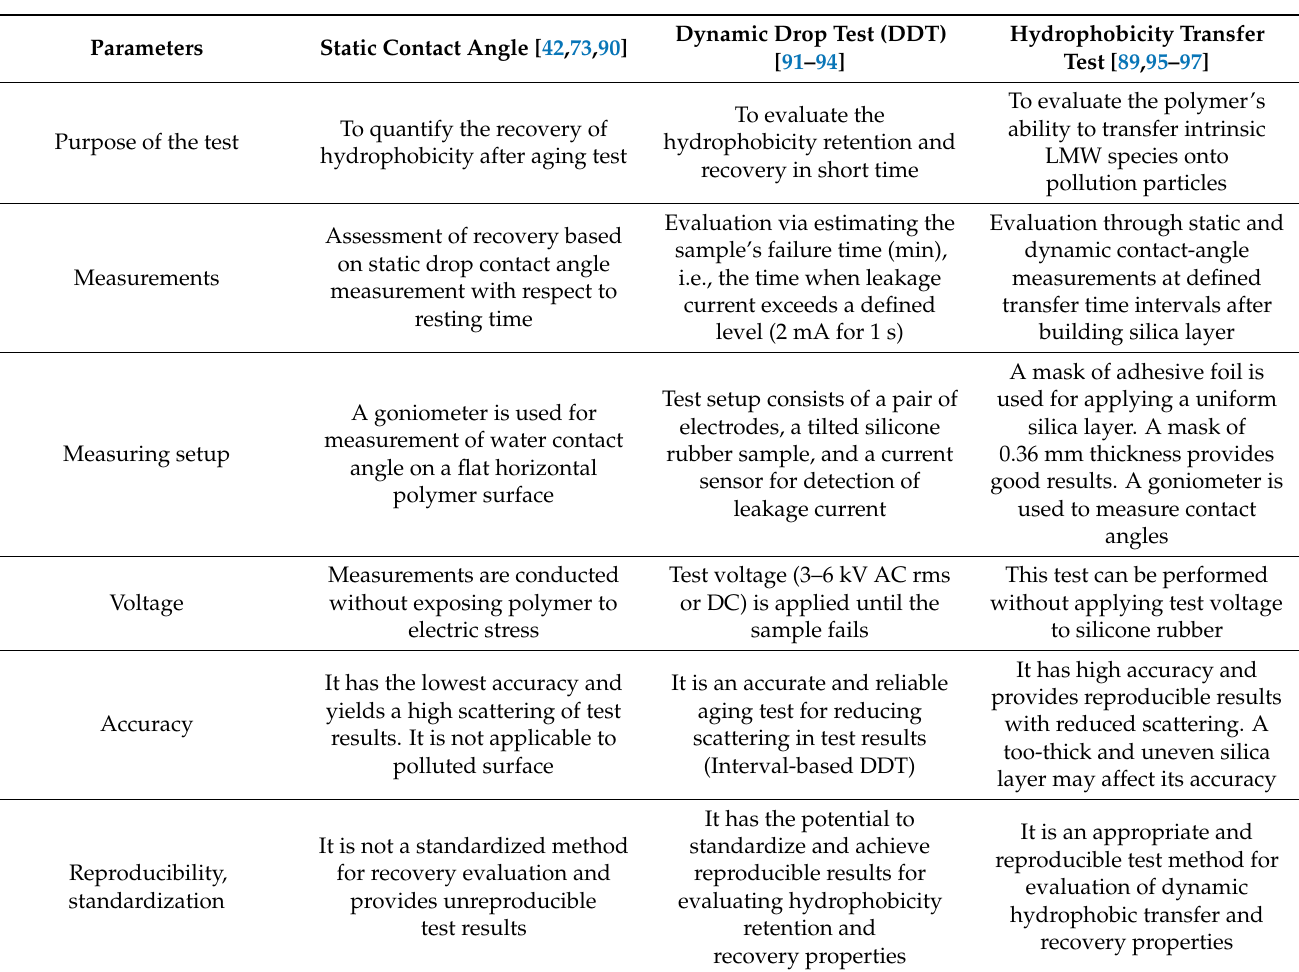
Table 1. Comparison of developed methods for evaluation of